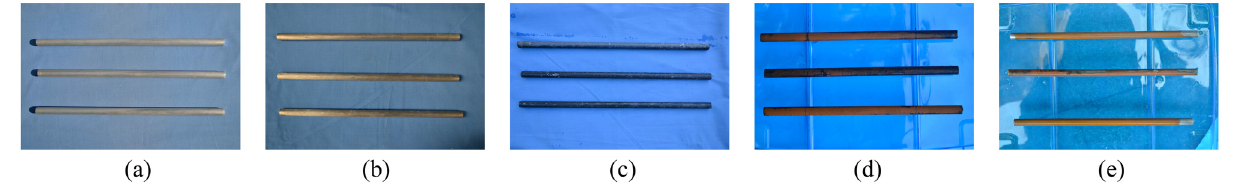
Figure 5: Surface state of the specimens after immersion for 72 h: ( a ) 1#, ( b ) 3#, ( c ) 5#, ( d ) 7#, and ( e ) 9#.